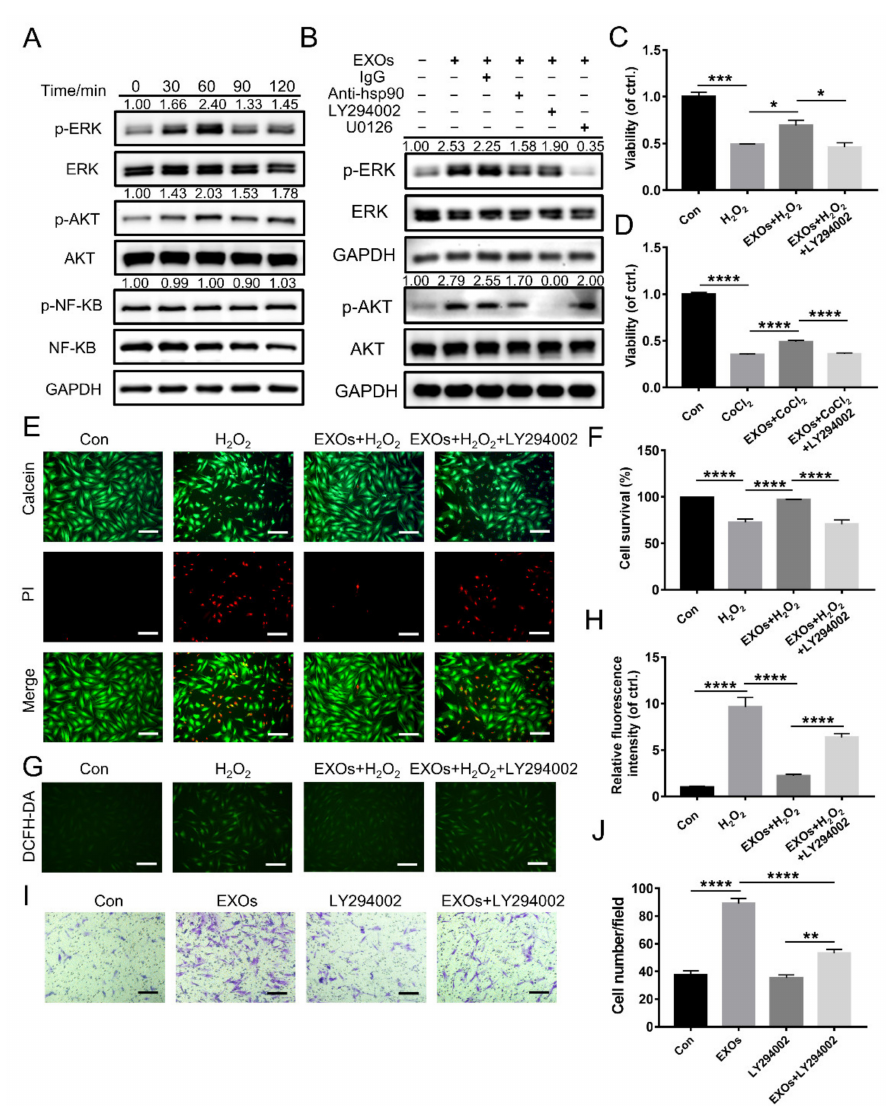
Figure 4. The effect of ADSC-EXOs relied on the activation of AKT signaling pathway. ( A ) Western blot analysis of the activation of AKT, ERK, and NF- κ B pathways in fibroblasts after treated with ADSC-EXOs at different times ( n = 3). ( B ) Representative blots showing the activation of AKT and ERK pathways in fibroblasts following various treatments ( n = 3). Fibroblasts were pre-treated with EXOs, EXOs + LY294002, or PBS for 24 h; then exposed under H 2 O 2 for 6 h or CoCl 2 for 24 h; and finally assessed by the following assays. ( C ) CCK8 analysis of the cell viability of fibroblasts under H 2 O 2 exposure in each group. ( D ) CCK8 analysis of the cell viability of fibroblasts under CoCl 2 exposure in each group. ( E ) Evaluation of the fibroblasts viability by Calcein-AM/PI staining. ( F ) Quantitative analysis of the data in ( E ). ( G ) Representative DCFH fluorescent images of fibroblasts in each group. ( H ) Quantitative analysis of the relative fluorescence intensity in ( G ). ( I ) Representative micrographs of migratory fibroblasts given above treatments. ( J ) Quantitative analysis of the data in ( I ). n = 5. Scale bar: 100 µ m. * p < 0.05, ** p < 0.01, *** p < 0.001, **** p <